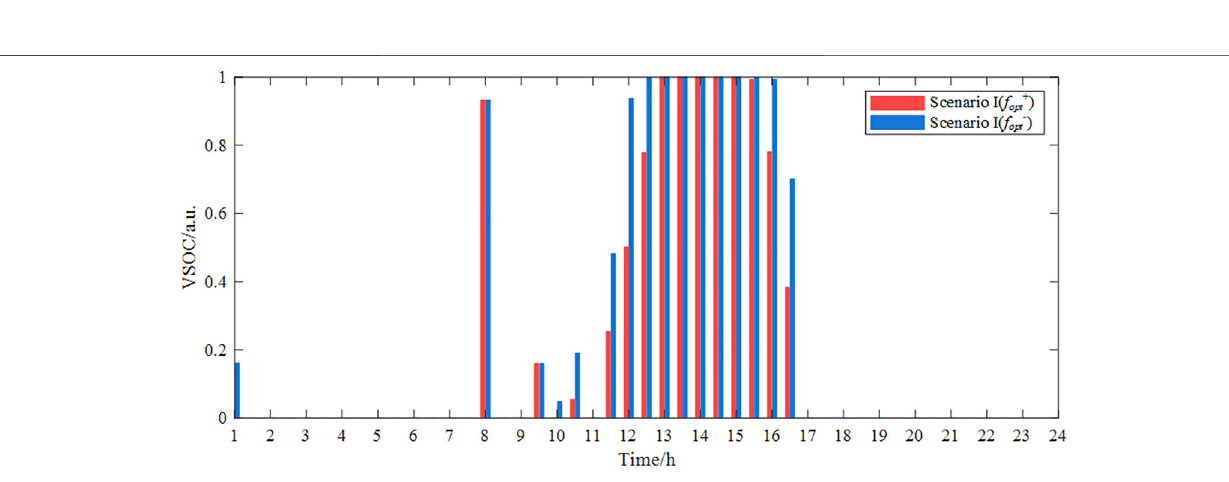
Frontiers in Energy Research |